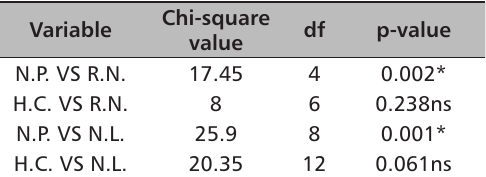
TABLE 2. Effect of hormone concentration and nodal position on root and leaf production of D. tripetala